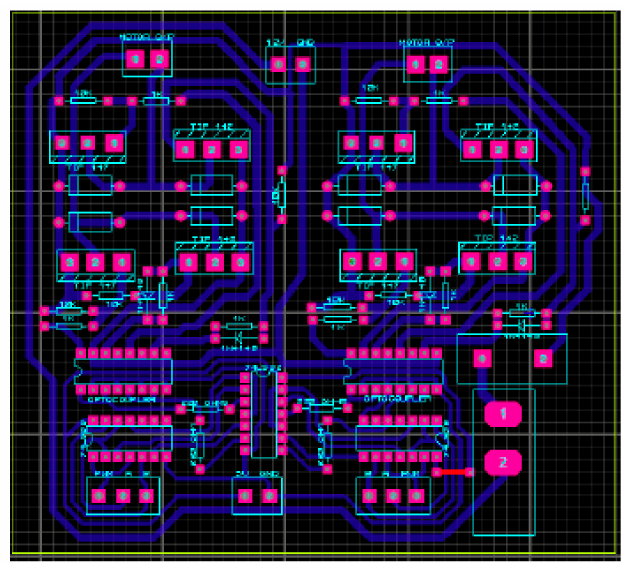
Figure 11. PCB Design of H-Bridge.